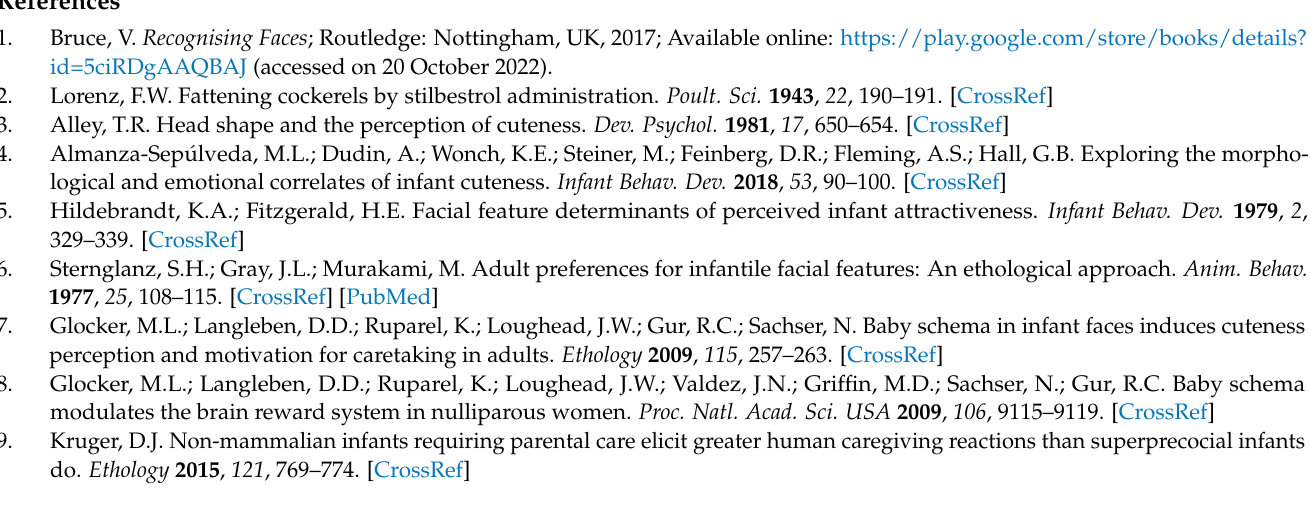
breds; Table S2: List of Fe-BARQ sections; Table S3: Attributes of the survey participants (whether they own cats, like cats, or like